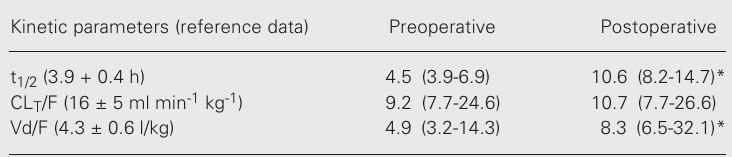
Figure 1. Plasma propranolol lev- els before and after coronary ar- tery bypass grafting with hypo- thermic cardiopulmonary by- pass. The filled circles indicate preoperative measurements and the open circles postoperative measurements. The dashed line shows the linear regression of preoperative plasma propranolol levels and the dotted line shows the linear regression of postop- erative levels. Data are reported as median and 95% confidence